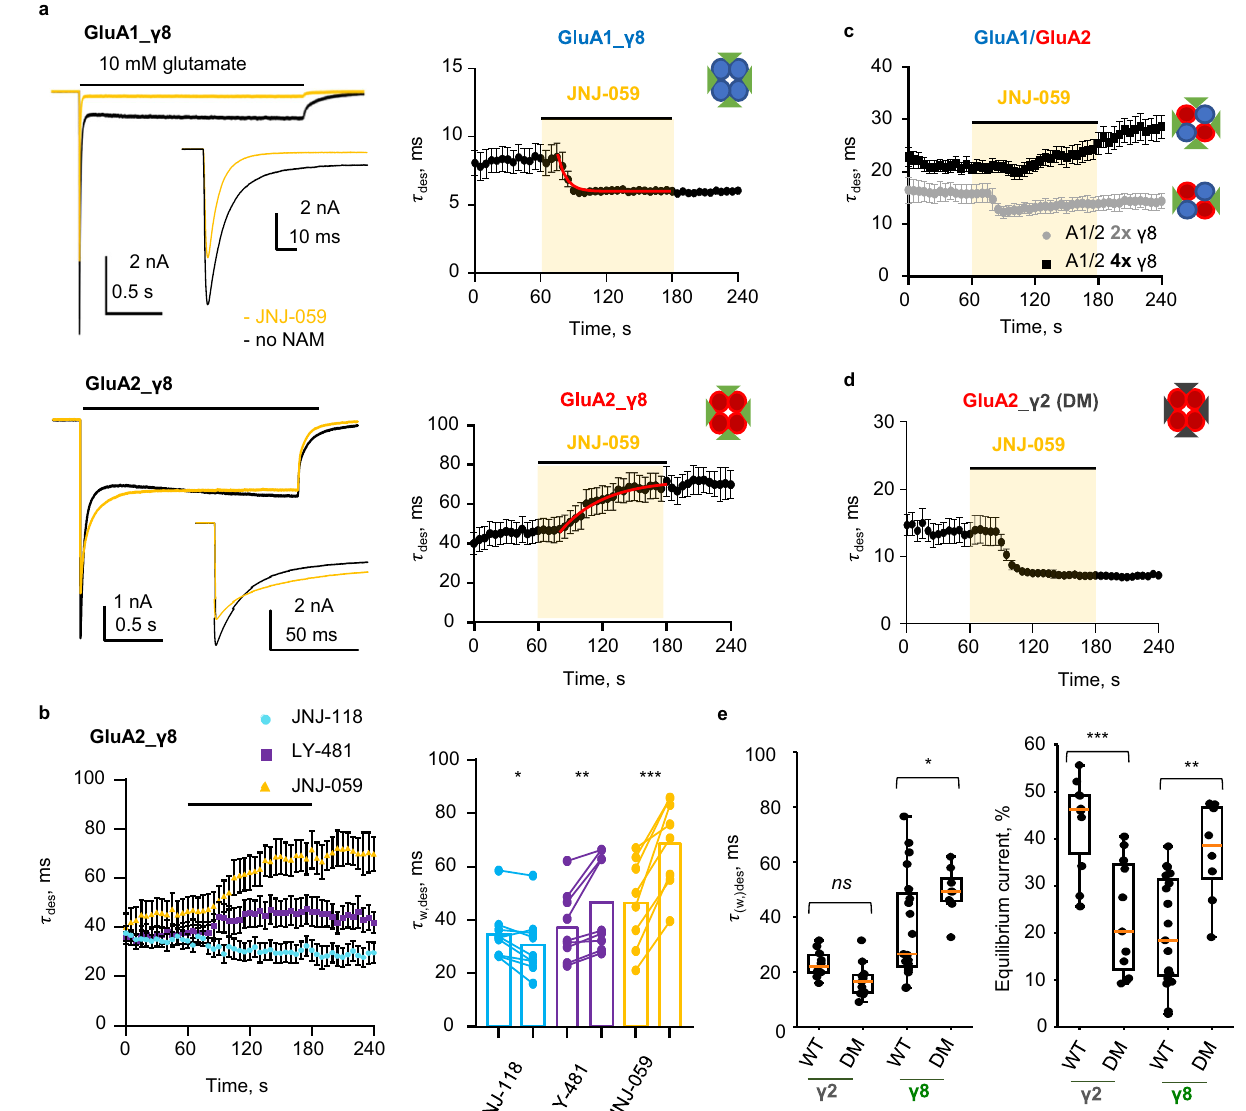
Fig. 6 | JNJ-059 PAM action on GluA2-containing AMPARs associated with four γ 8 subunits. a Left: Representative whole-cell responses to 10mM glutamate (2seconds, − 60mV) from HEK293T cells transfected with GluA1_ γ 8 (top; repeated from Fig. 4 to facilitate direct comparison) or GluA2Q_ γ 8 (bottom) tandem in control condition (black) and in presence of JNJ-059 10 µ M (orange). Insets show initial phase of currents at faster time scale. Right: Scatter plot of average desen- sitization τ overtimeindicatingthetime-courseofJNJ-059effectonGluA1_ γ 8( n =7; top;repeatedfromFig.4c)orGluA2Q_ γ 8( n =8;bottom).Blackcirclesandwhiskers indicate average values and SEM. Red line is a fi t of the pooled data with a single exponential ( τ =7.2ms and 40.4ms for GluA1_ γ 8 and GluA2Q_ γ 8, respectively) for display purposes only. b Left: Scatter plot of average desensitization τ in time indicating the time-course of modulator effect on GluA2Q_ γ 8. Black circles and whiskersindicateaveragevaluesandSEM.Numberofcellsare n =9forJNJ-118, n =9